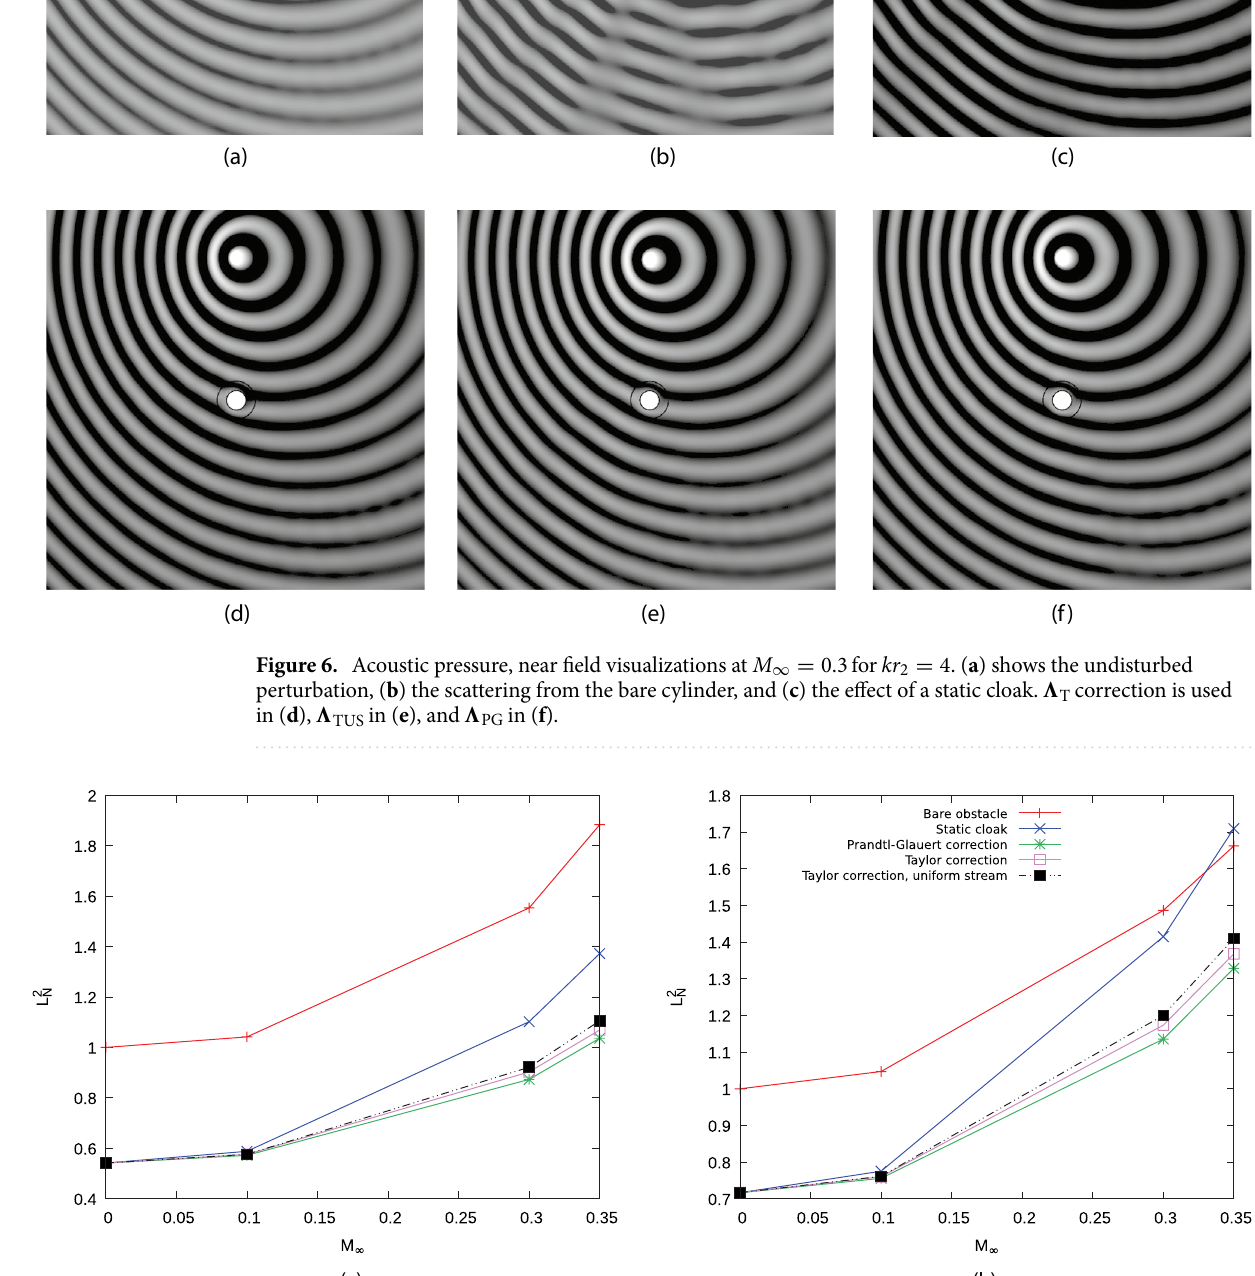
2 ( a ), kr 2 4 ( b ). The scattering norm for kr 2 = = ∞